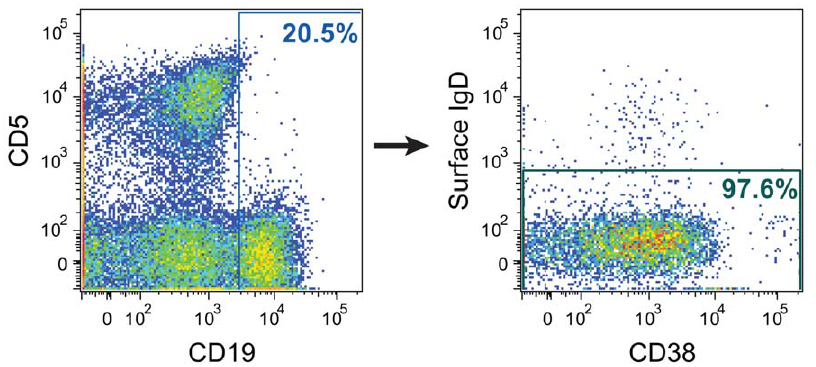
Figure 1. Memory B cell isolation from colostrum of an HIV-1-infected, lactating woman. Colostrum cells were stained with fluorescent mAbs for relevant B cell molecules, and analyzed flow cytometrically prior to selecting the target sort population. Following geometric gating and exclusion of dead and CD3/CD14/CD16/CD235a + cells, CD19 + , surface IgD- colostrum B lymphocytes were selected as shown in this figure and sorted into 96 well plates. The colostrum CD19 + B cells were primarily negative for surface IgD expression and CD38 2 / + , consistent with memory B cells. CD5 expression of colostrum-derived B cells was largely absent.